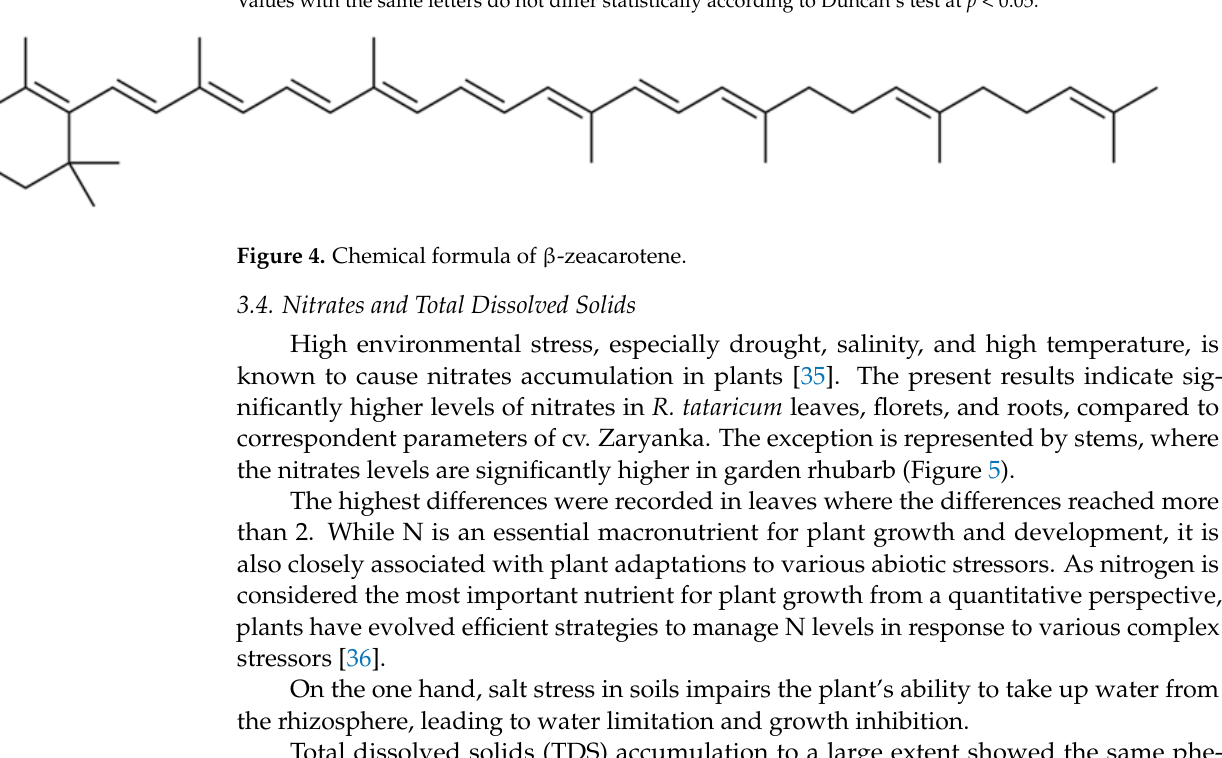
Table 2. Proline content in rhubarb root peel and pulp (mg kg − 1 d.w.). Tissue R. tataricum